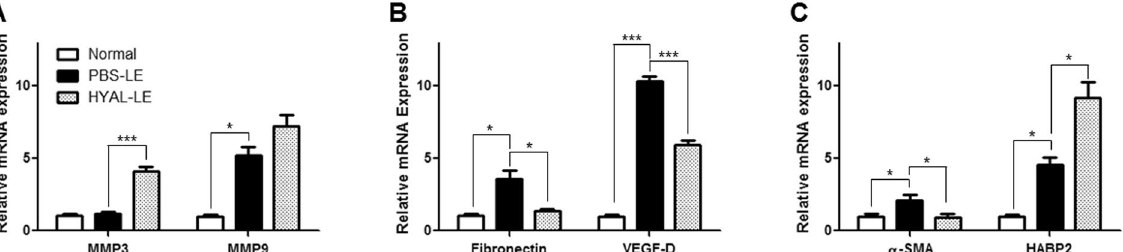
Figure 4. Hyaluronidase injection induces anti-fibrotic responses. Molecular analysis of mouse leg lysates. ( A–C ) Quantitative real-time PCR analysis of VEGF-D, fibronectin, MMP3, MMP9, α -SMA and HABP2. ( A ) Increased expression levels of MMP3 and MMP9 were observed, ( B ) Whereas decreased expression levels of VEGF-D, and fibronectin were observed in the hyaluronidase-injected mice. ( C ) The expression of α -SMA was decreased with hyaluronidase treatment, but HABP2 expression was increased. Data are presented as means ± SEMs. * P < 0.05, *** P <